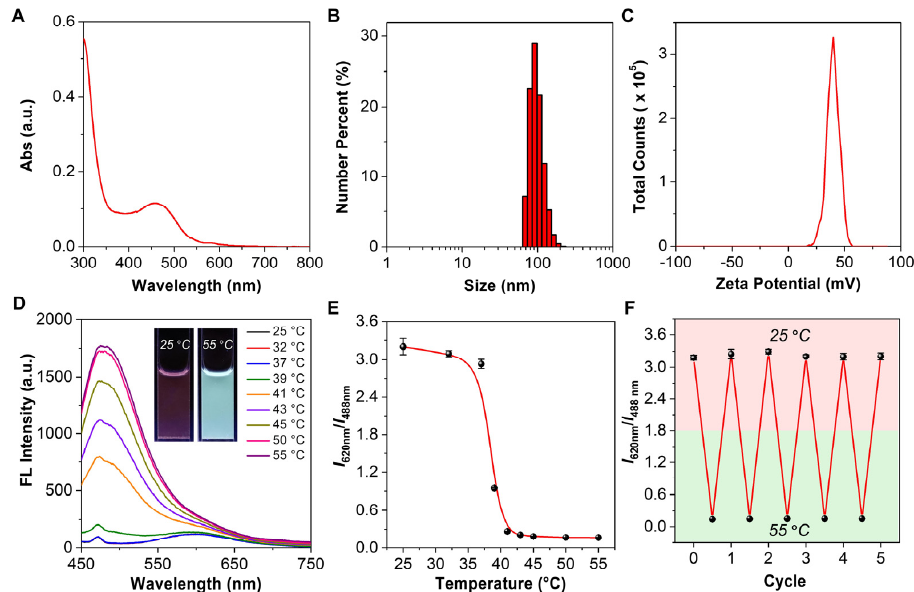
Figure 4. Detailed characterizations of the physiochemical properties of NG-3 in water. ( A ) Absorp- tion spectrum of NG-3. ( B ) Particle size distribution of NG-3 (0.25 mg mL − 1 ) at 55 ° C. ( C ) Plot of the zeta potential of NG-3 at 55 ° C. ( D ) Temperature-dependent emission spectra of NG-3 (0.25 mg mL − 1 ) in water. Ex = 405 nm. Inset: fluorescence photographs of NG-3 (0.25 mg mL − 1 ) at 25 and 55 ° C, respectively, taken under a 365 nm UV lamp. ( E ) Changes in the ratio of the emission intensity at 620 and 488 nm as a function of temperature ( n = 3). ( F ) Changes in the ratio of the emission intensity at 620 and 488 nm for repeated heating and cooling cycles between 25 and 55 ° C ( n = 3). Table 1. Thermometric performance of NG-3 at different temperatures.